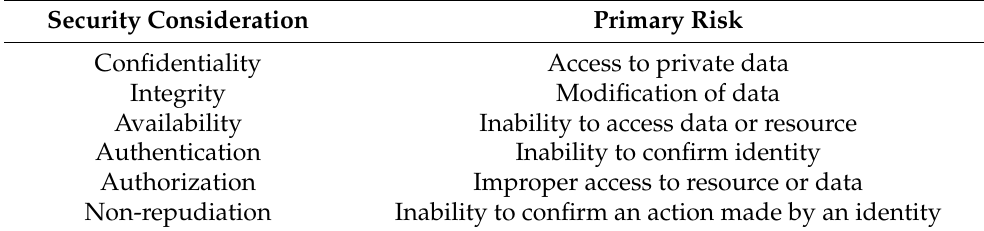
Table 1. Summary of security